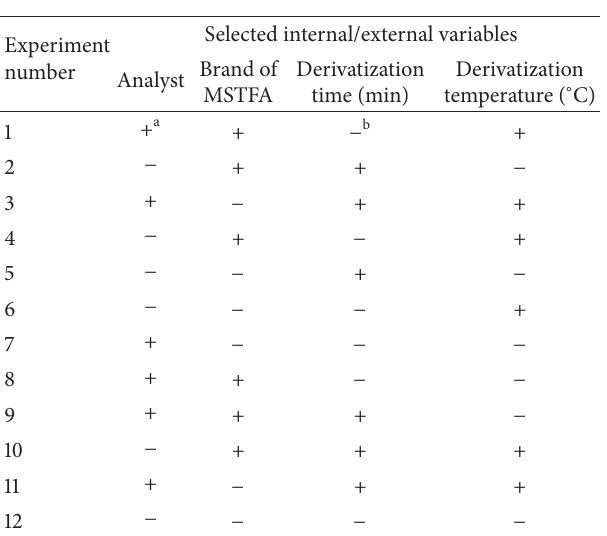
Table 2: Conducted experimental runs for robustness and rugged- ness